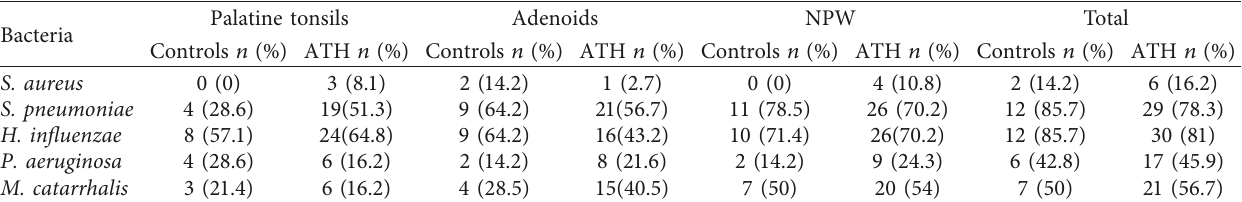
Table 2: Detection rates of bacteria in tonsillar tissues and nasopharyngeal washes from patients with adenotonsillar hypertrophy and